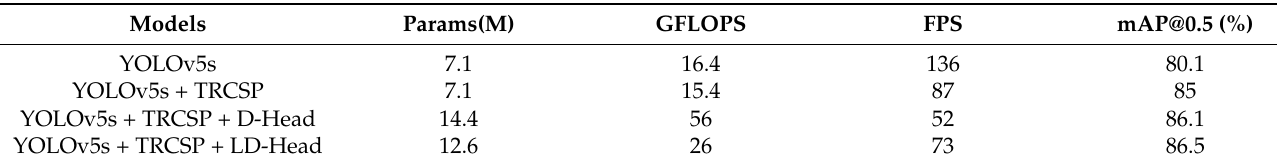
Table 5. Real-time detection evaluation.